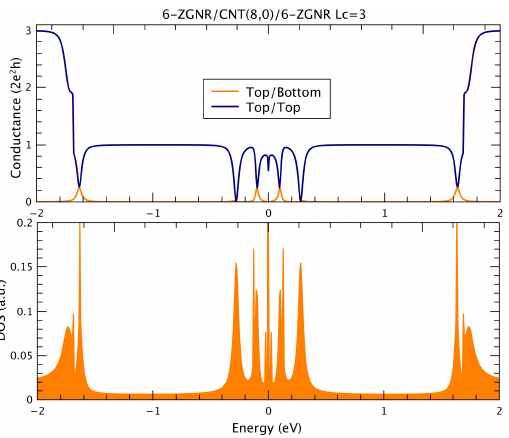
Figure 2. T/T (dark blue curve) and T/B (orange curve) conductance results ( top panel ) and DOS ( bottom panel ) for a 6-ZGNR/CNT(8,0)/6-ZGNR